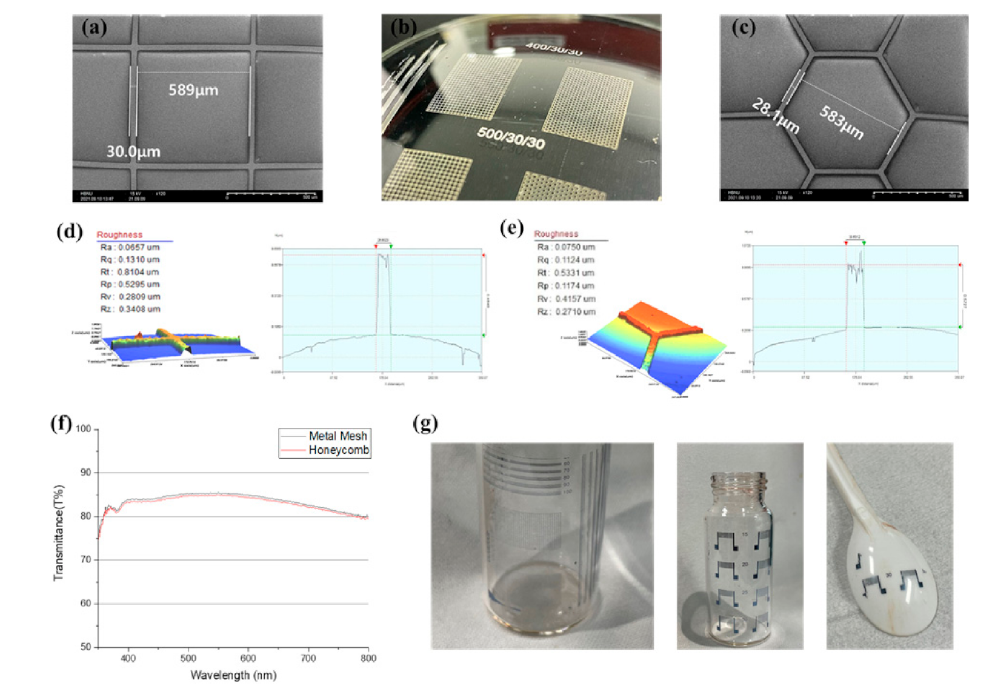
Figure 6. ( b ) Printed transparent electrodes on a 3D curved surface and SEM images of the printed ( a ) metal mesh and ( c ) honeycomb, Table 3. 3D image and roughness profile of metal mesh transparent electrodes and ( d ), ( e ) the 3D image and roughness profile, measured using a 3D scanner, of metal mesh type and honeycomb pattern transparent electrodes. ( f ) Optical transmittance spectra of metal mesh and honeycomb transparent electrodes. ( g ) Sample possibilities printed on various curved